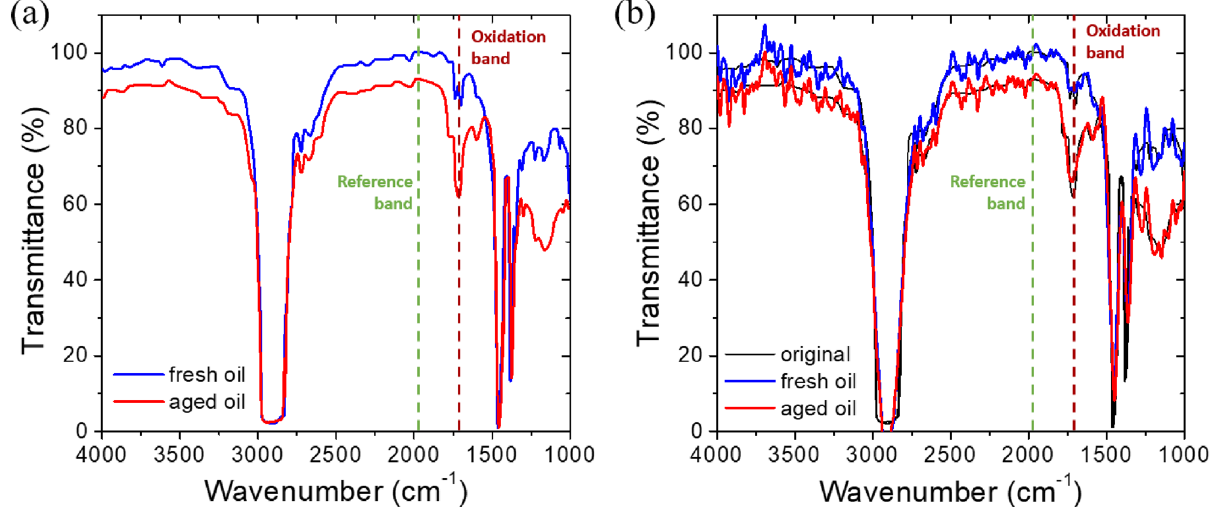
Figure 8. ( a ) FTIR spectra of fresh and aged oils (reproduced with permission from Ref. 38 where the aged oil was obtained by artificially deteriorating an engine oil SAE 10W40 according to a standard CEC method 40 at 160 °C for 8 days). ( b ) The recovered spectra using Tikhonov regularization, where thin black solid lines indicate the original